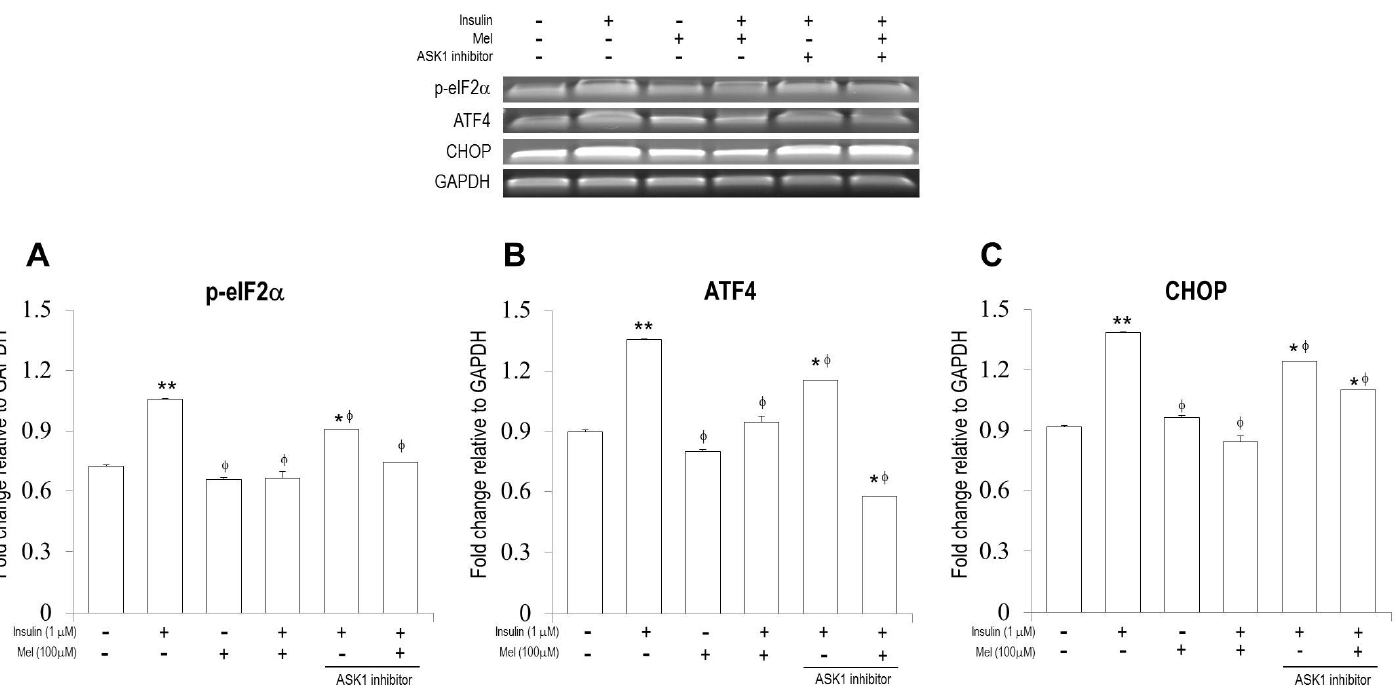
Figure 3. Melatonin regulates IR-induced endoplasmic reticulum (ER) stress signaling (p-eIF2 α , ATF4, and CHOP) in the SH-SY5Y neuronal cells. The mRNA levels of ( A ) activation of eIF2 α , (p-eIF2 α ); ( B ) ATF4, and ( C ) CHOP were measured by reverse transcription PCR. Data are expressed as mean ± standard error and each experiment included three repeats per conditions. * p < 0.05, ** p < 0.01 compared with non-stimulated control; φ p < 0.05 compared with insulin stimulated cells. Mel: melatonin pretreatment for 24 h before insulin stimulation; ASK1 inhibitor: NQDI-1 600 nM treatment for 2 h before sampling.